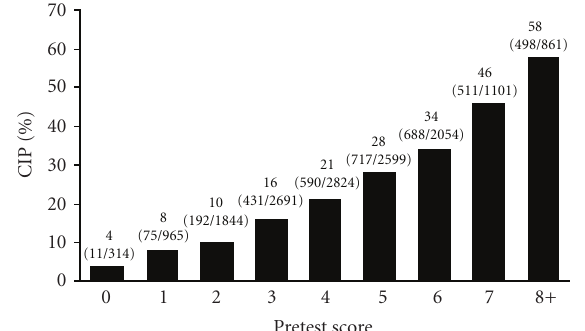
Figure 4: Cumulative incidence proportion (CIP) of contrast agent use according to pretest score. Below the x -axis label, the denominators indicate the number of patients with each score and the numerators indicate the corresponding subset of patients who had contrast agent use. “8+” indicates an individual score of 8, 9, 10, or 11.